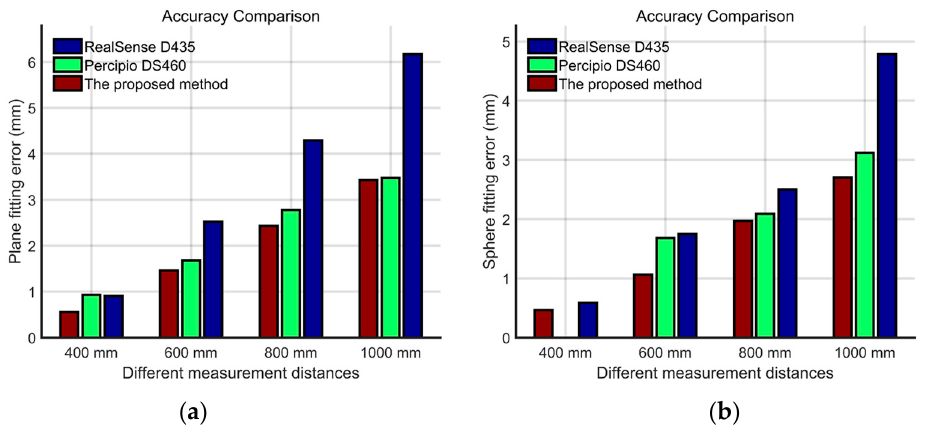
Figure 13. Accuracy comparison between D435, Kinect v2, and our system: ( a ) plane-fitting errors and ( b ) sphere-fitting errors.